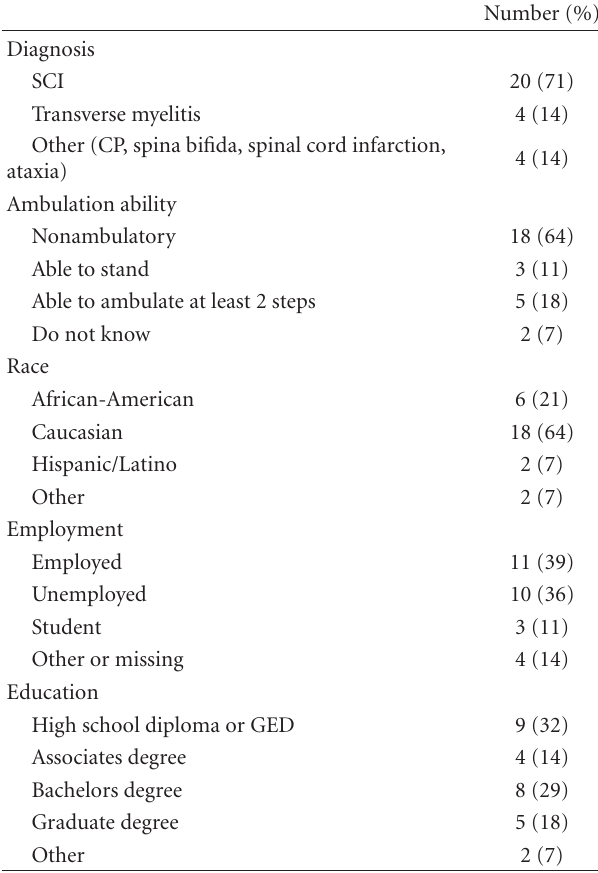
Table 2: Subject characteristics.